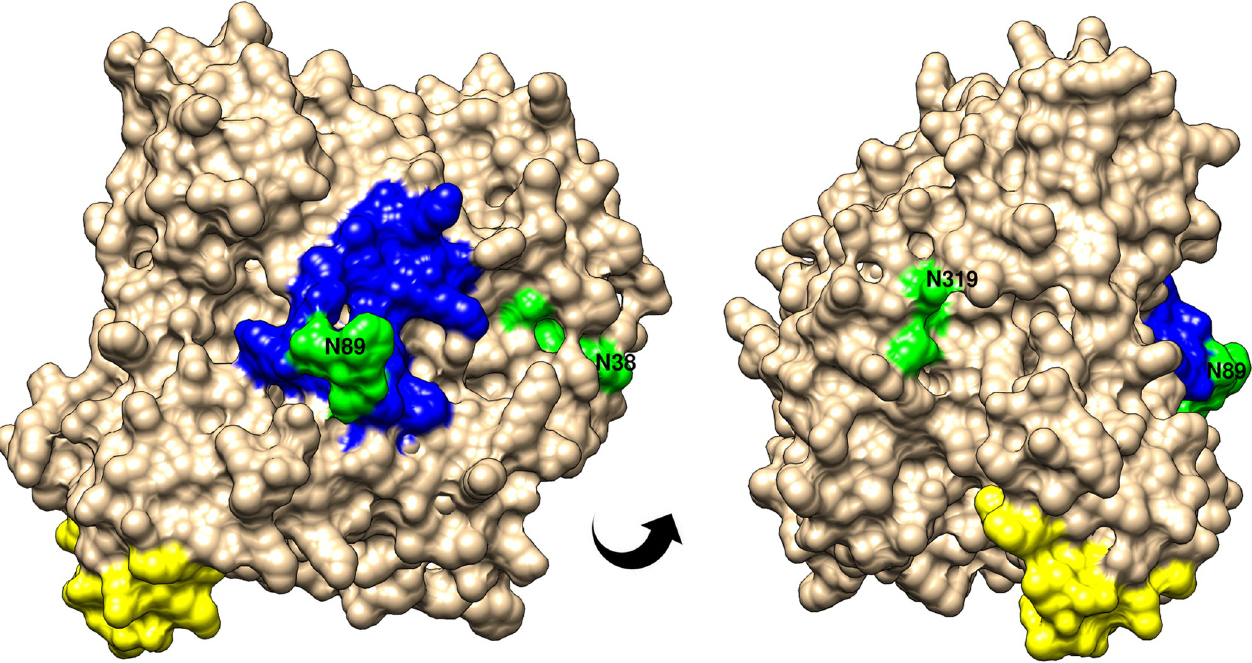
Fig 6. Strongyloides stercoralis acetylcholinesterase in rotated views showing surface-exposed epitope regions and N-linked glycosylation sites. Accession number SSTP_0000509400. Predicted features indicated in colour: blue, BepiPred 2.0 predicted epitope at residues 85–103; and yellow at 390–411; green, predicted N-linked glycosylation sites at N38 (NVT), N89 (NFS) and N319 (NLT). The site at N89 is within the blue epitope sequence. Both predicted epitope regions (blue and yellow) were selected as candidate coproantigens in this study. These results originate from methods shown in Fig 1, boxes